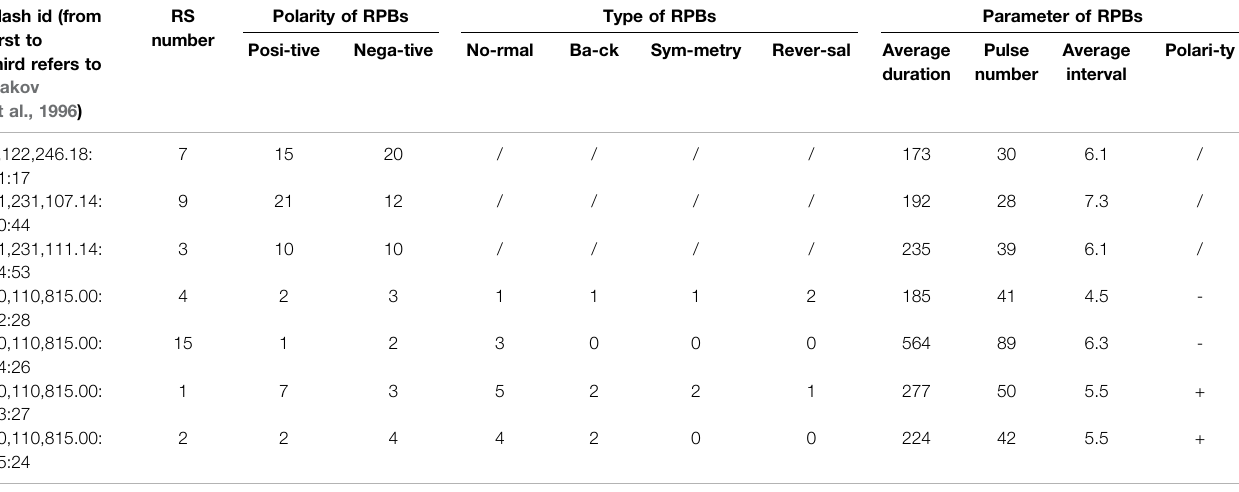
TABLE 1| Statistical comparison ofdata from CG. Rows one tothree are statistical data given by Rokav et al., 1996; rows fi ve tosix arestatistical data of – CG from Qinghai; and rows seven to eight are statistical data of +CG from Qinghai. Flash id (from fi rst to third refers to Rakov